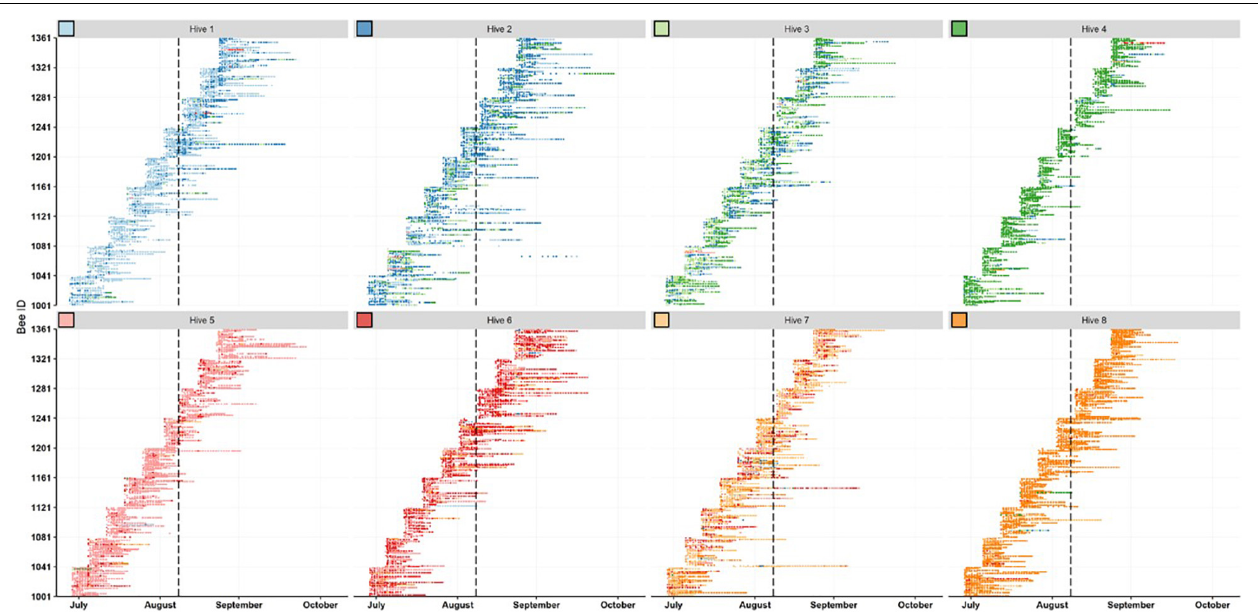
FIGURE 3 | Foraging activity span of all bees during the 4-month study period. Each row represents the RFID scans of an individual bee, with the specific colors corresponding to their respective natal hives. Therefore, bees that matched the color with their nest of origin are natal workers whereas different colors within a hive represent the activity of foreign drifter workers. In total 2,880 bees were tagged in nine separate sessions demonstrated by the ladder-like appearance along the y axis. That is, at every session 40 tagged bees were introduced per colony. The vertical dashed line shows when the colony entrances were marked, 42 days after the beginning of the experiment. The experimental period ran for another 78 days until no tagged bees could be observed in the